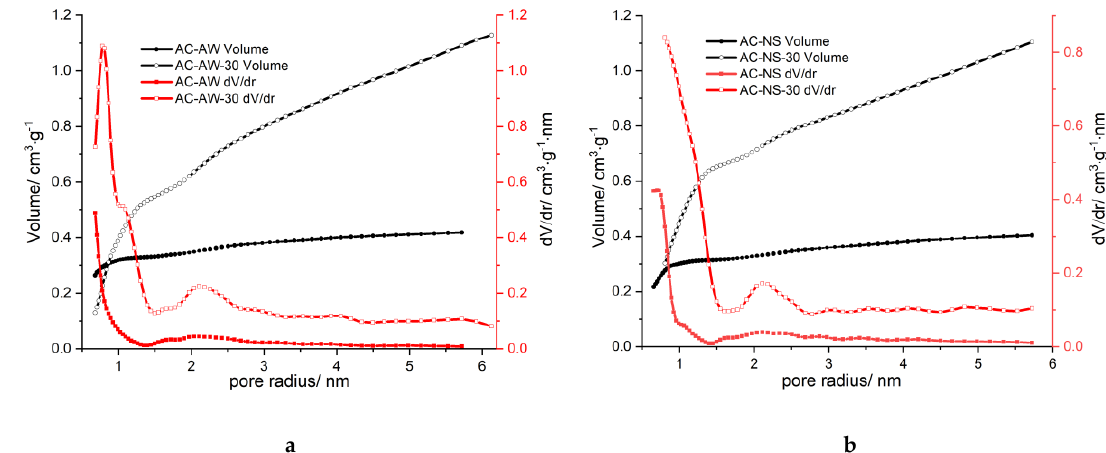
Figure 2. Pore size distributions, dV / dr , calculated from ( a ). the N 2 adsorption–desorption and ( b ). Isotherms on activated carbons, as function of pore radius, r .